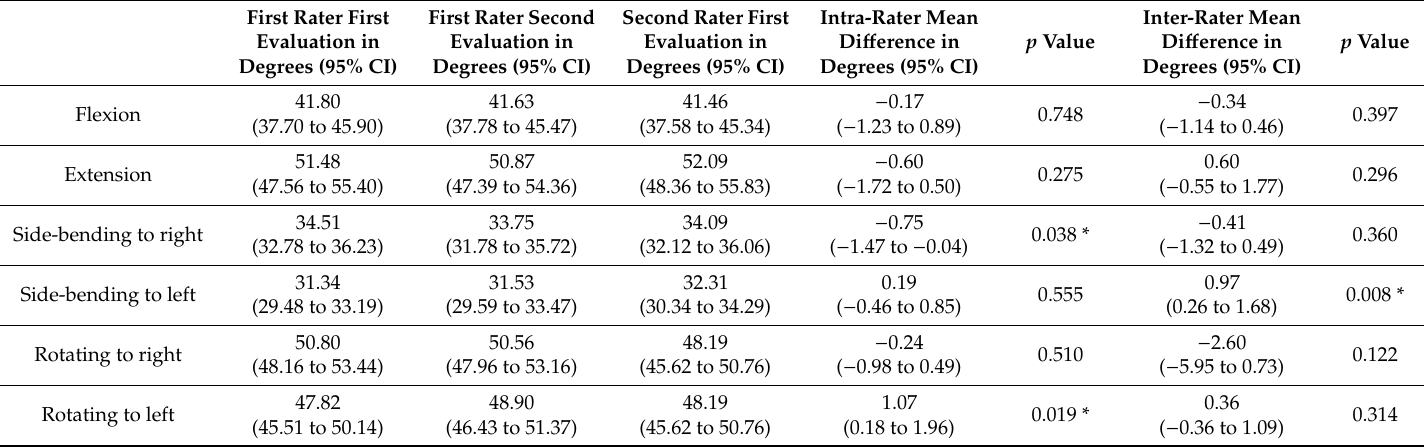
Table 1. Intra-rater and inter-rater evaluations and corresponding di ff erences of craniocervical ranges measured by the hybrid device.